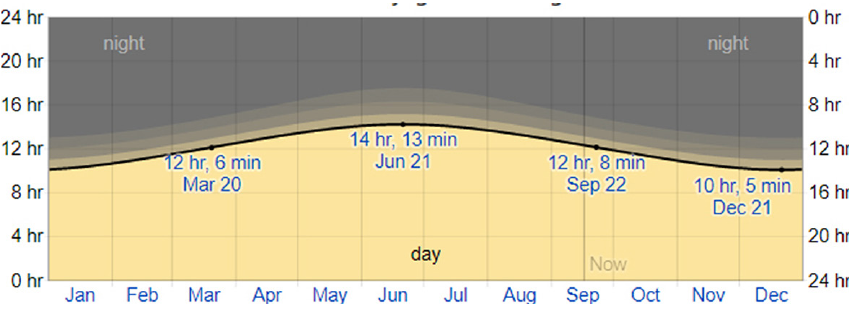
Fig. 3. Average of daylight